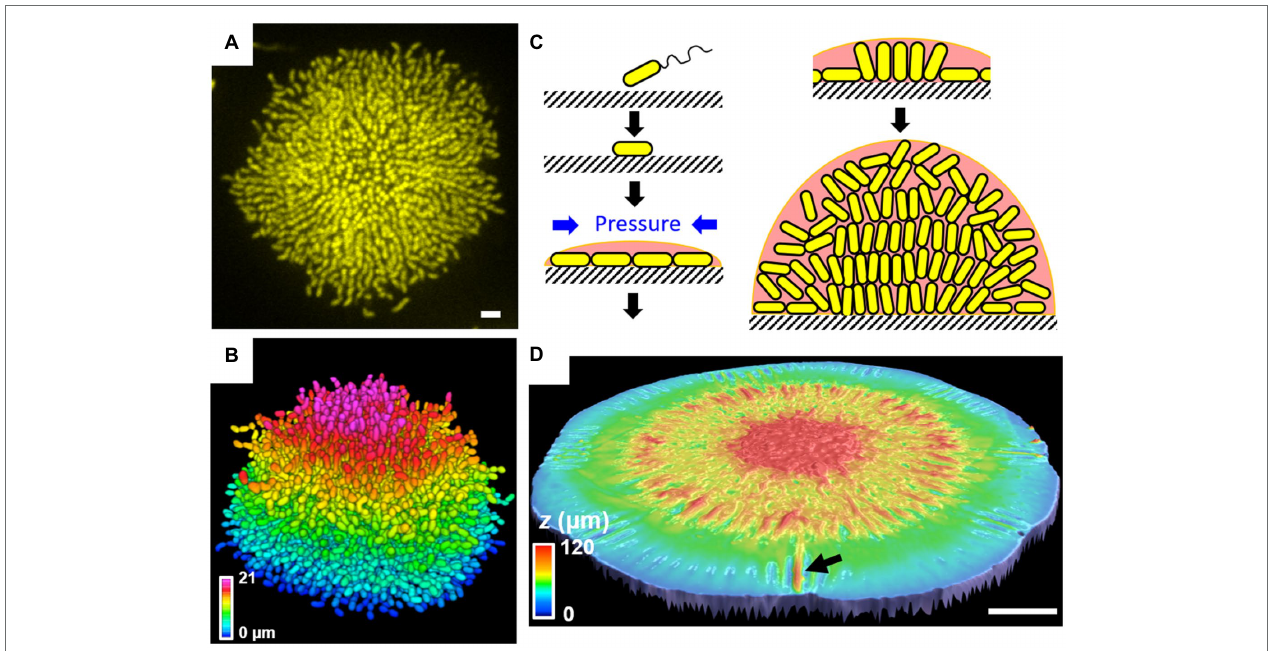
FIGURE 6 | Single-cell live imaging of V. cholerae biofilms. (A) Cross-sectional image of the bottom cell layer of a growing V. cholerae biofilm cluster at 18 h and (B) the corresponding segmented image with color coding according to the z position. Scale bar: 3 μ m. (C) Schematic model of the V. cholerae biofilm growth process. (D) Surface topography of a V. cholerae colony biofilm grown on 0.5% agar at the onset of the wrinkling-to-delamination transition (36 h). The arrow indicates a delaminated blister. Scale bar: 2 mm. Panels (A – C) are adapted with permission from Yan et al. (2016); panel (D) is adapted with permission from Yan et al.